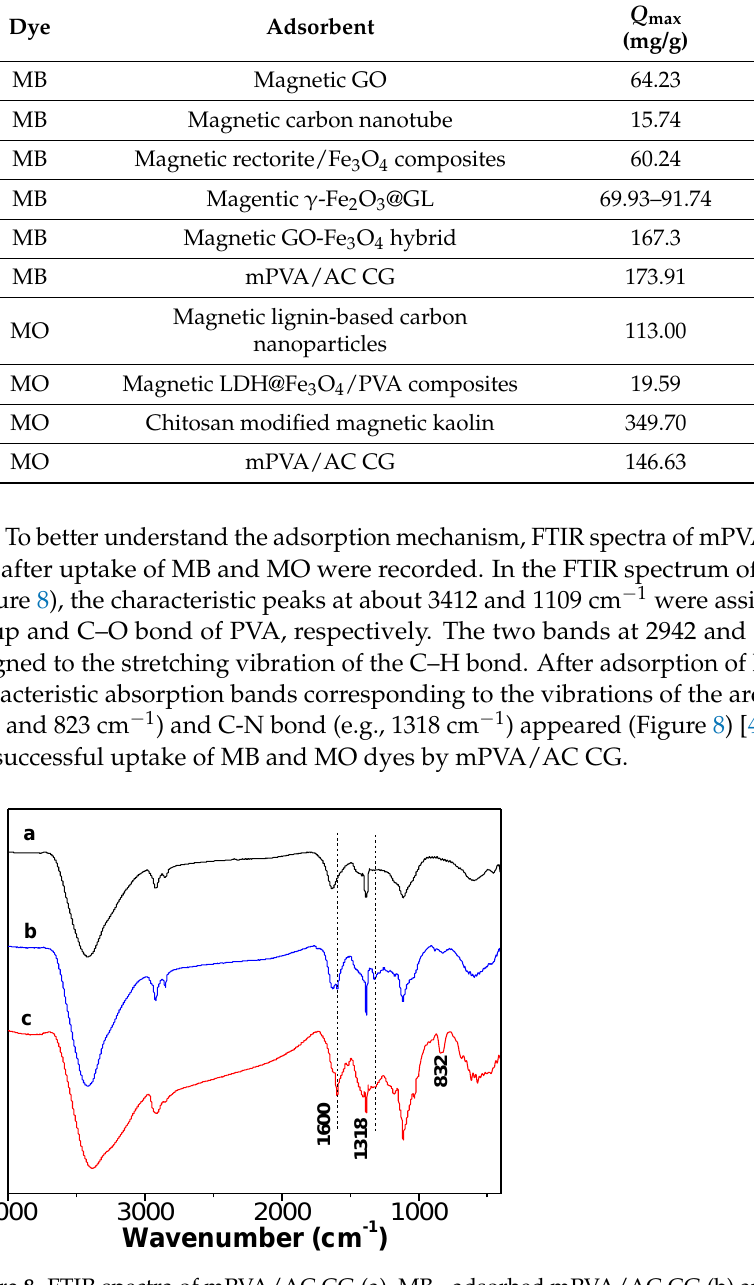
Figure 8. FTIR spectra of mPVA/AC CG (a), MB − adsorbed mPVA/AC CG (b) and MO − adsorbed mPVA/AC CG (c).